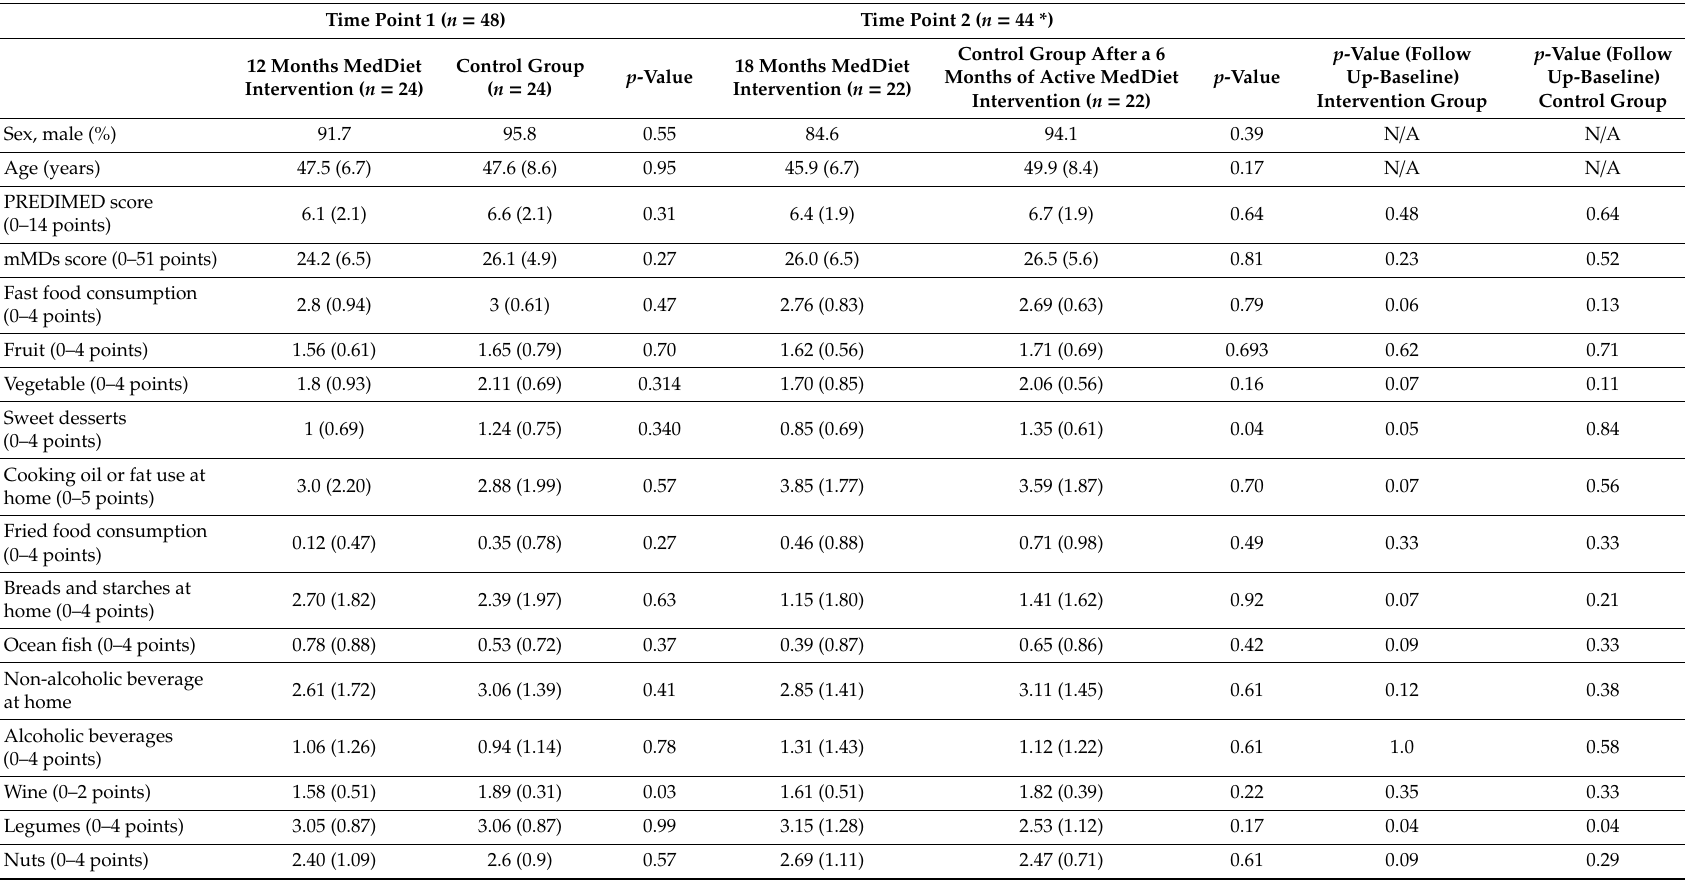
Table 1. Characteristics of the firefighters participating in the Feeding America’s Bravest intervention